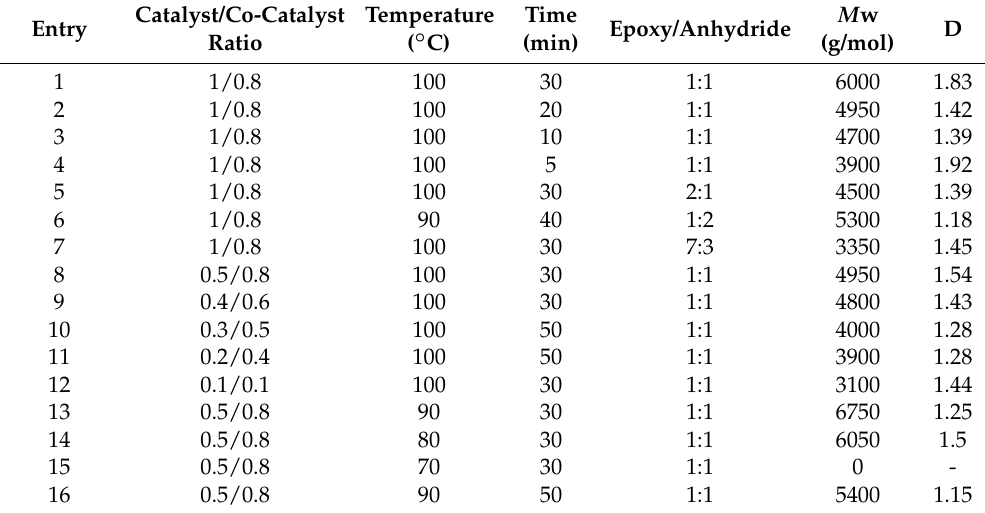
Table 1. Co-polymerization of epoxide and phthalic anhydride using (salen)Cr III Cl as catalyst and n-Bu 4 NCl as